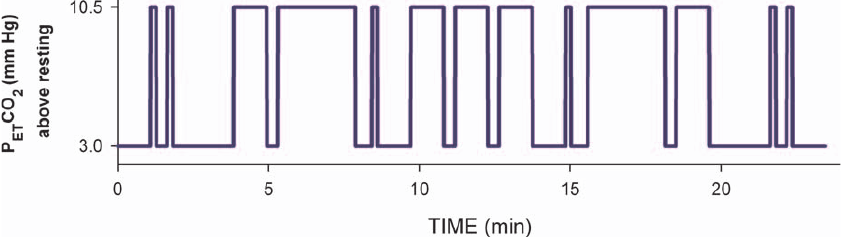
Figure 1. The Multifrequency Binary Sequence in P ET CO 2 In this study we applied two of the shown (approximately 23.5 min) sequences in succession.